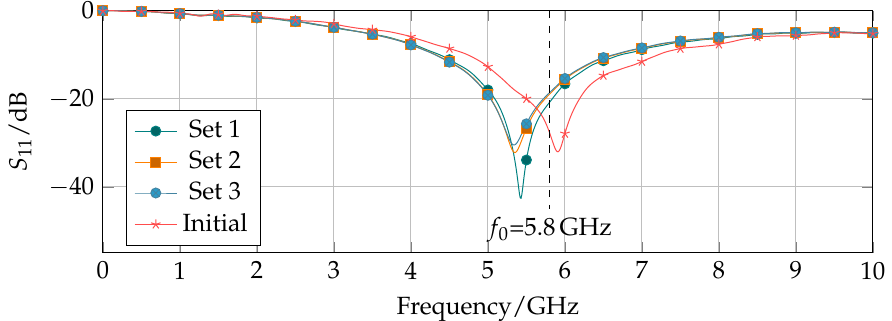
Figure 5. Reflection coefficient of three Pareto-optimal parameter sets for the dual-mode applicator inserted into liver